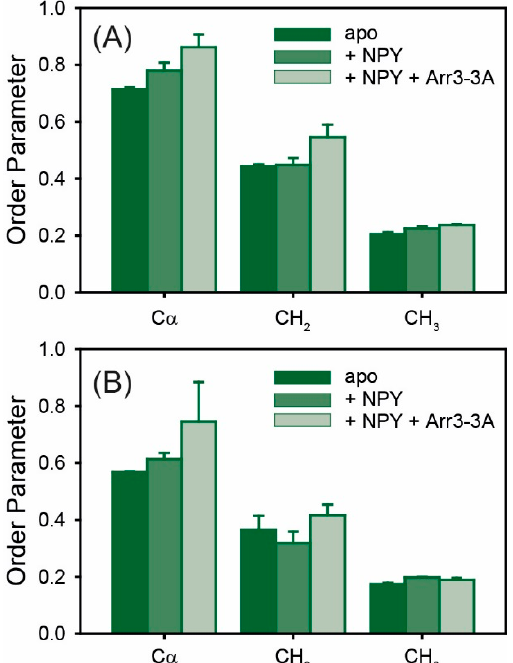
Figure 4. DipShift 1 H- 13 C order parameters of Y1R in the apo, NPY-bound state, or in complex with NPY and Arr3-3A determined by DipShift experiment using CP at a contact time of 700 µ s ( A ) or direct excitation ( B ). Error bars represent the experimental error determined from two independent preparations and measurements.